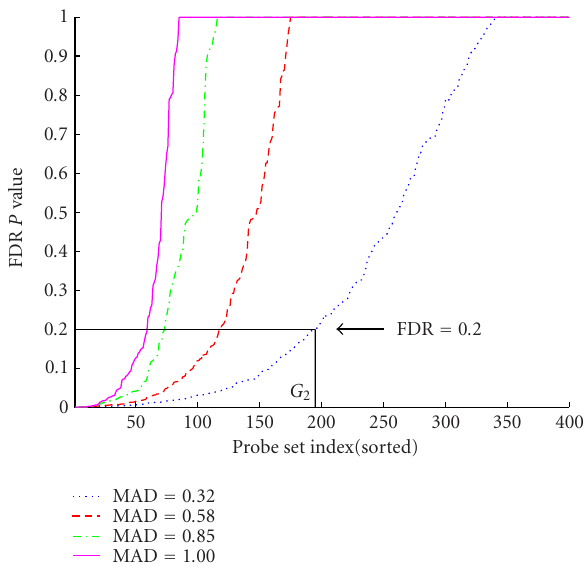
Figure 4: Plots of FDR P value curves over sorted list of gene indices for four values of the MAD criterion: fcmin = 0 . 32,0 . 58,0 . 85,1 . 0 (log base 2) corresponding to wild-type/knockout MAD ratios of 1 . 25, 1 . 5, 1 . 8, and 2 . 0, respectively. Constraints FDR ≤ 0 . 2 and foldchange > 0 . 32 determine a set (cid:1) 2 of G 2 di ff erentially expressed genes by thresholding the corresponding curve as